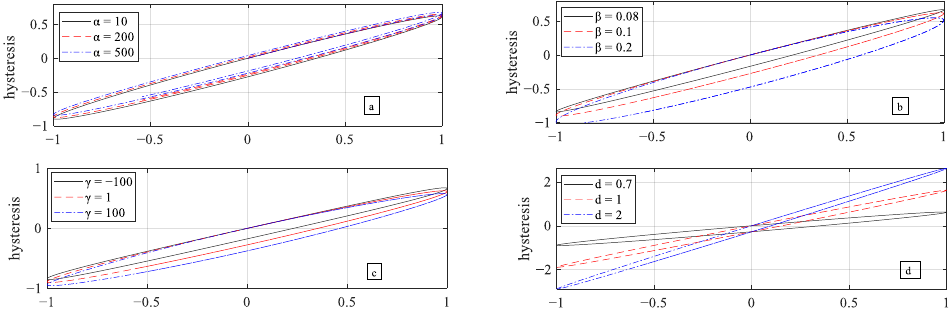
Figure 2. Change in hysteresis curve of the Duhem model with change in different